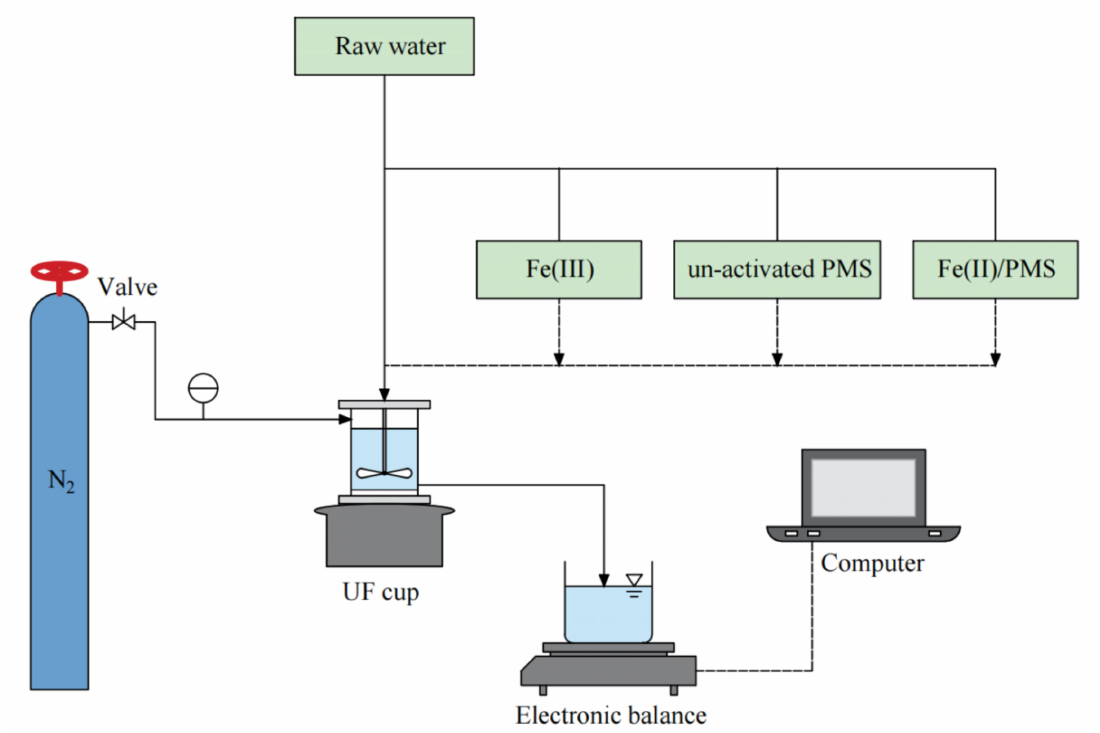
Figure 1. Ultrafiltration system